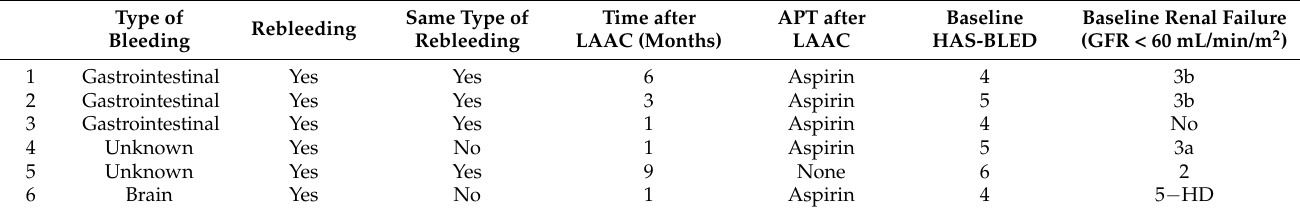
Table 2. Learning curve for LAAC with the LAmbre™ device ( n =